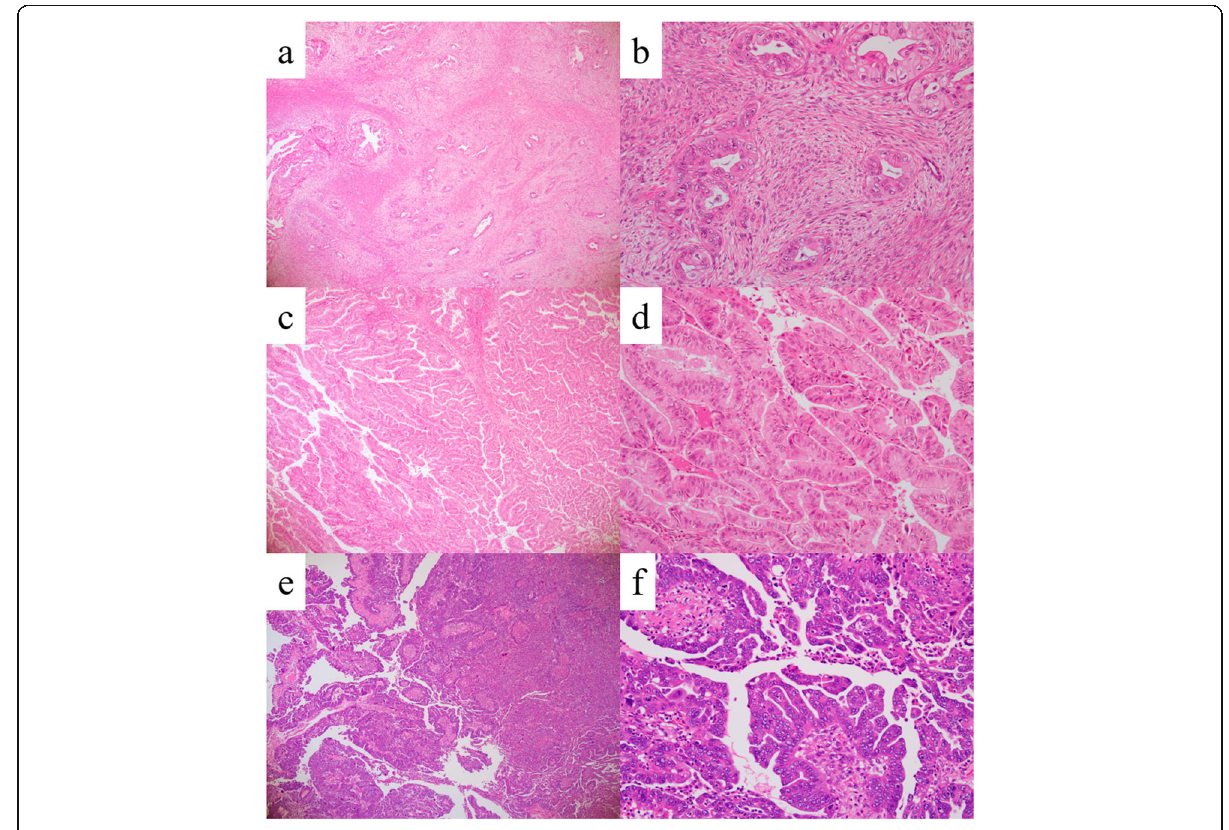
Fig. 1 Representative images of mucinous carcinoma (MC) with infiltrative invasion and MC with expansile invasion. A MC with infiltrative invasion was characterized by obvious evidence of destructive stromal invasion. (x40) ( B ) Stromal invasion consisted of malignant glands, cell nests, and a desmoplastic stromal reaction (x200). C MC with expansile invasion was marked glandular crowding, creating a labyrinthine appearance with little intervening normal ovarian stroma (x40). D Back to back malignant glands were seen in MC with expansile invasion (x200). E HGSC was characterized by solid, papillary, labyrinthine with slit-like spaces, glandular, or cribriform architecture (x40). F Large and markedly atypical nuclei, with high mitotic activity including atypical mitoses, were seen